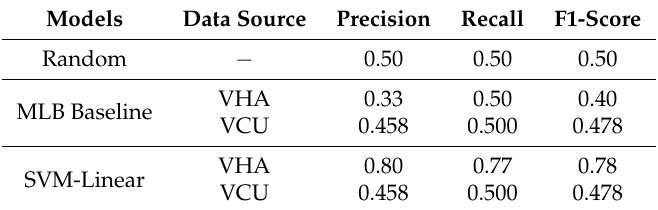
Table 4. Traditional machine learning approach results for Model-2 (Low vs. High severity prediction). Reported results are macro averaged. MLB: majority label